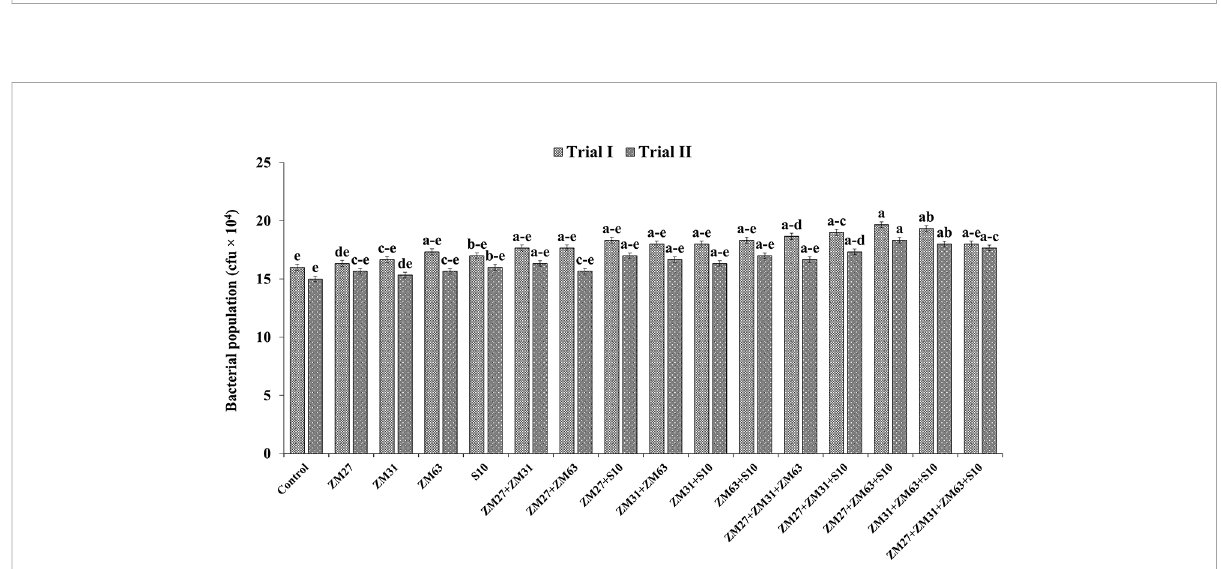
FIGURE 6 Effect of PGPR inoculation on the microbial count in maize rhizosphere in the fi eld trials. The bars with different letters are signi fi cantly different at p ≤